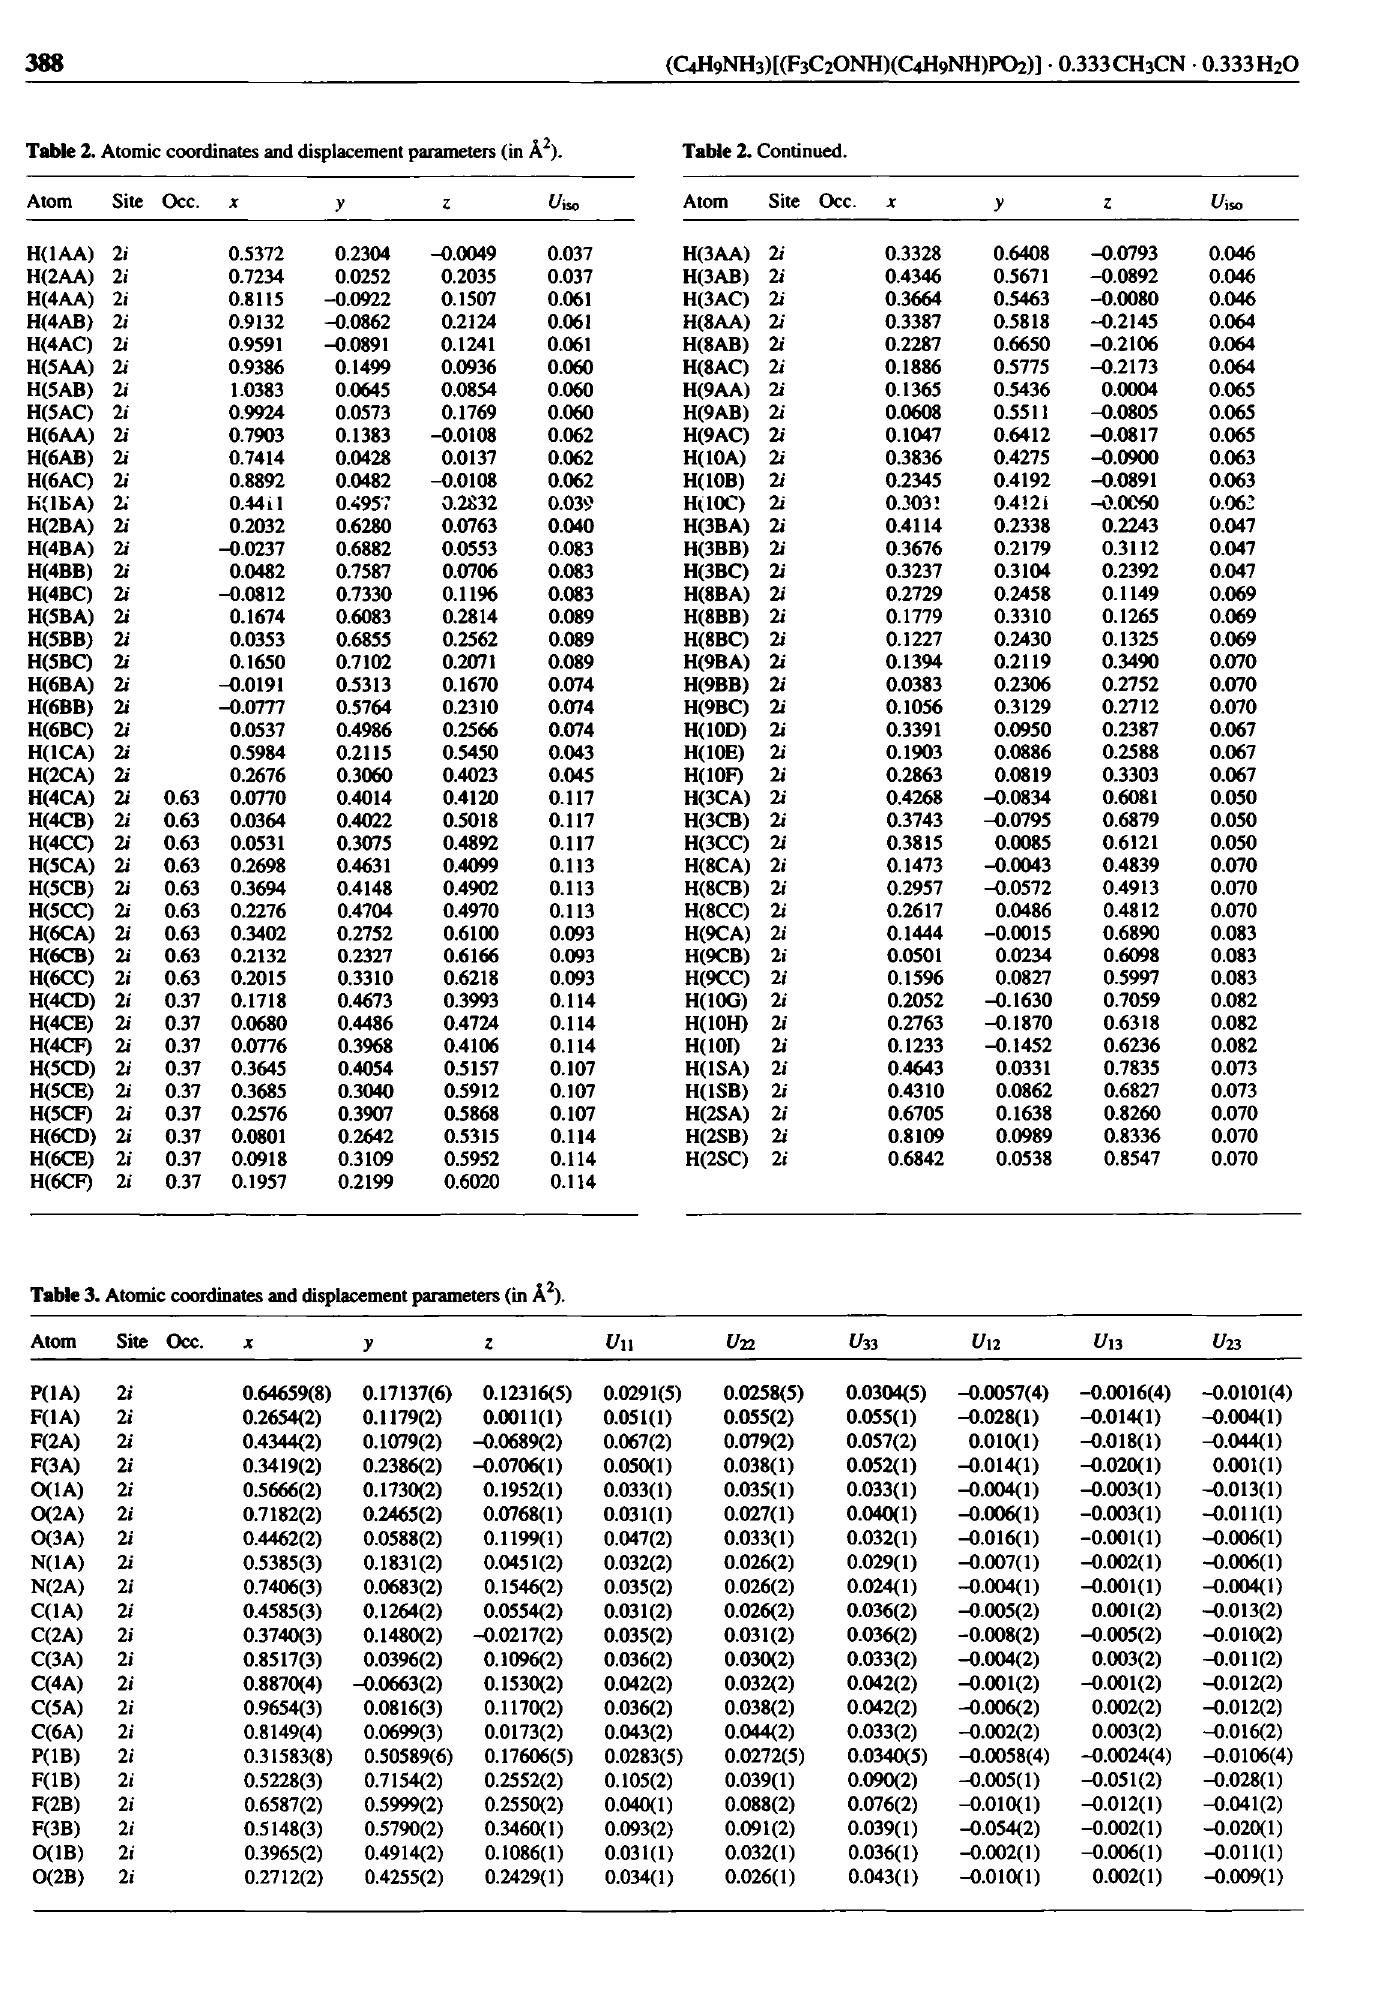
Table 3. Atomic coordinates and displacement parameters (in A 2